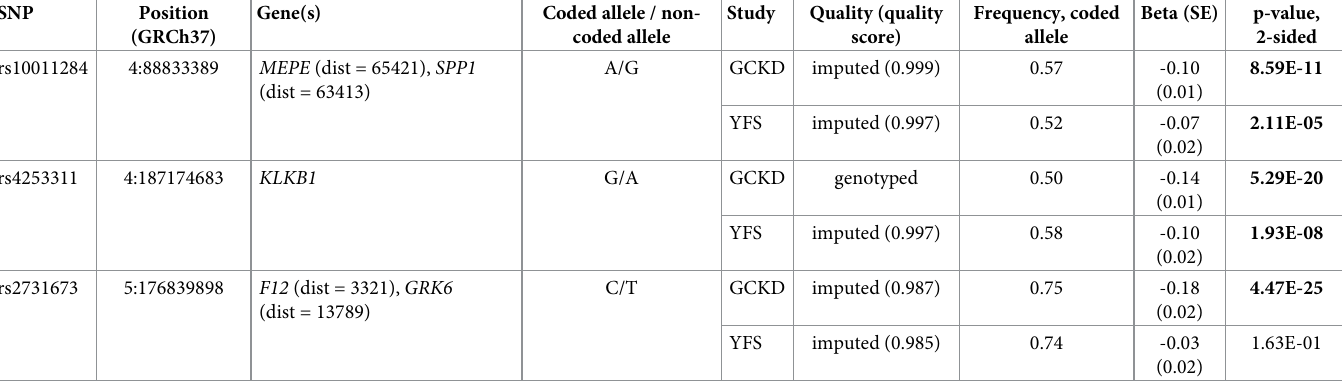
Table 2. Association results for the 3 index SNPs genome-wide-significantly associated with serum osteopontin levels in the GWAS discovery of the GCKD study (N = 4,897) and in the replication cohort of the YFS (N = 1,979). SNP Position